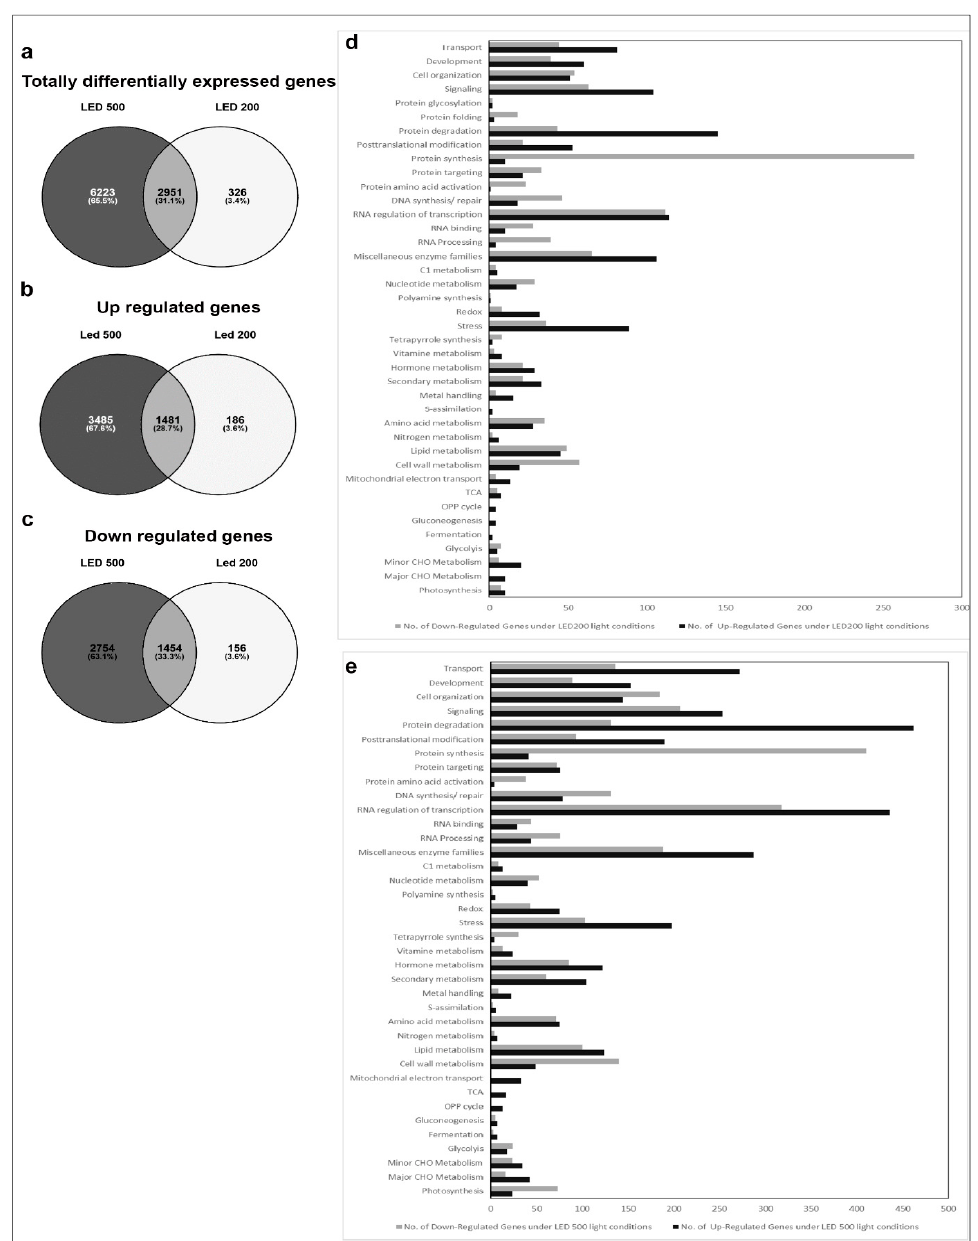
Figure 4. Comparative gene expression analysis of RNA isolated from plants grown in LED100, LED200 and LED500. ( a – c ) Venn diagrams of a total differentially expressed; ( b ) up regulated; ( c ) down regulated genes; ( d ) Bar chart of up (black bars) and down (grey bars) regulated genes from plants grown in LED200; ( e ) Bar chart of up (black bars) and down (grey bars) regulated genes from plants grown in LED500.